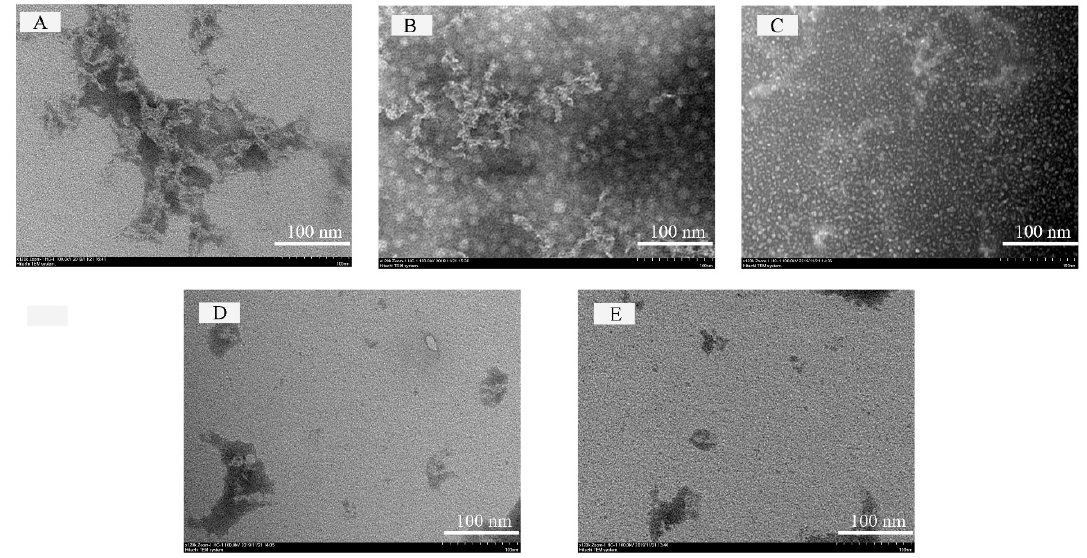
Figure 8. Transmission electron microscopy micrographs of PGWP and PGWP-SIF. PGWP ( A ); PGWP-SIF-A ( B ); PGWP-SIF-B ( C ); PGWP-SIF-C ( D ), and PGWP-SIF-D ( E ).